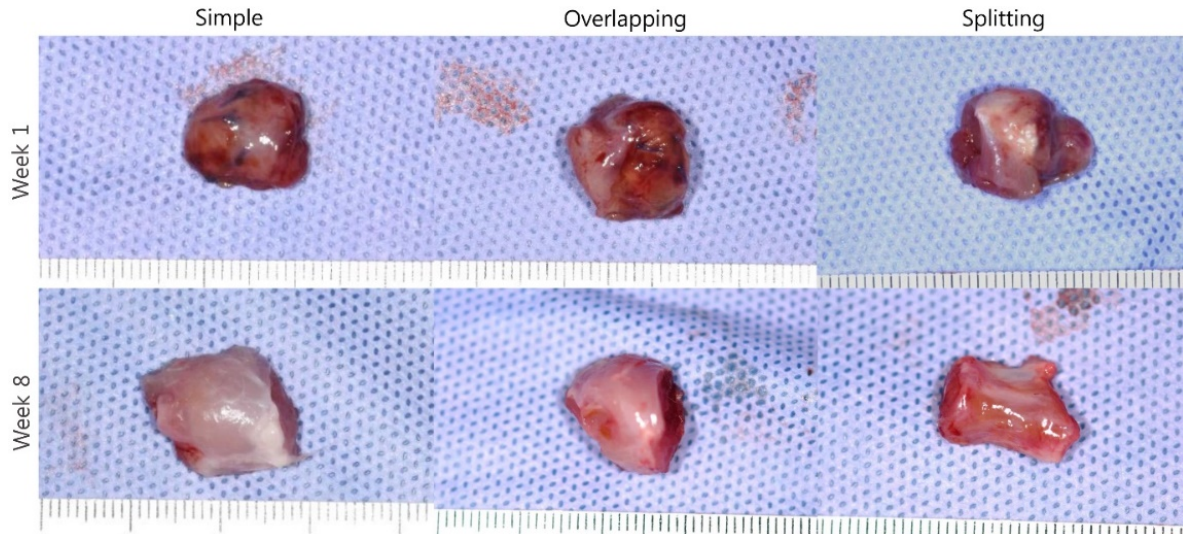
Figure 8. Immunohistochemical and Western blot analysis of TNF- α expression. At week 1, all groups showed strong expression of TNF- α in interstitial tissue by immunohistochemistry. The splitting suture group exhibited higher TNF- α levels than the overlapping and simple interrupted suture groups by Western blotting. The simple interrupted suture group exhibited weaker expression of TNF- α than the other groups by immunohistochemistry and Western blotting at week 8.